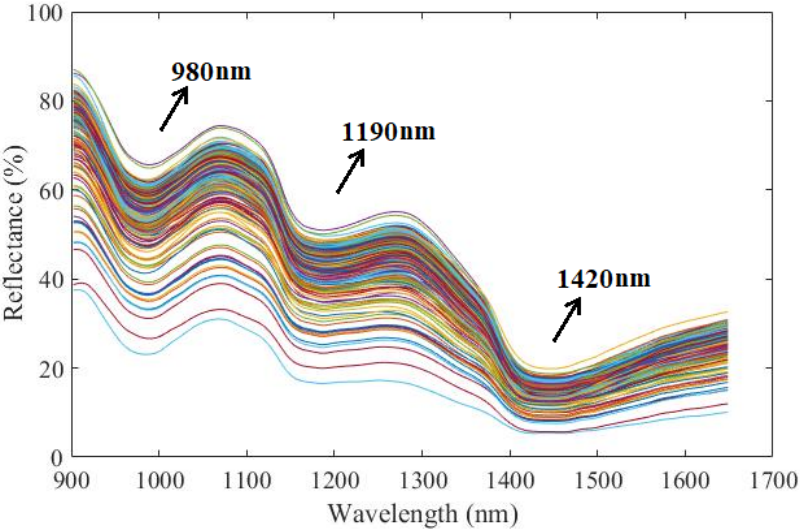
Figure 3. Original near infrared reflectance spectra of peaches. One curve stands for one sample. Spectral curves with different colors are convenient for readers to view the trend of spectra.